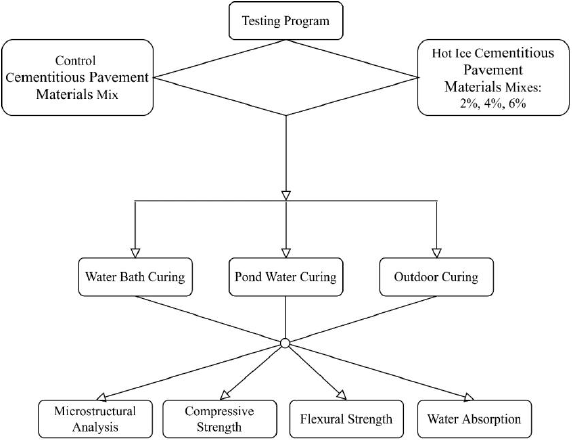
Figure 1. An overview of the experimental